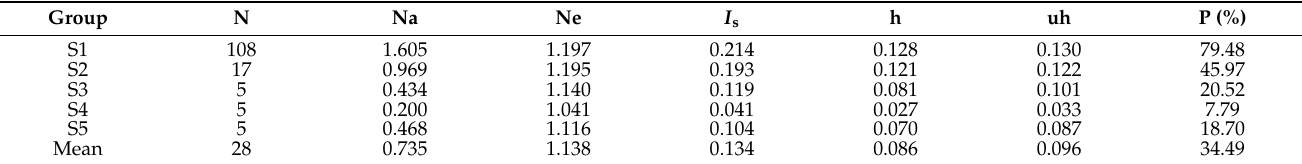
Table 4. The population average diversity